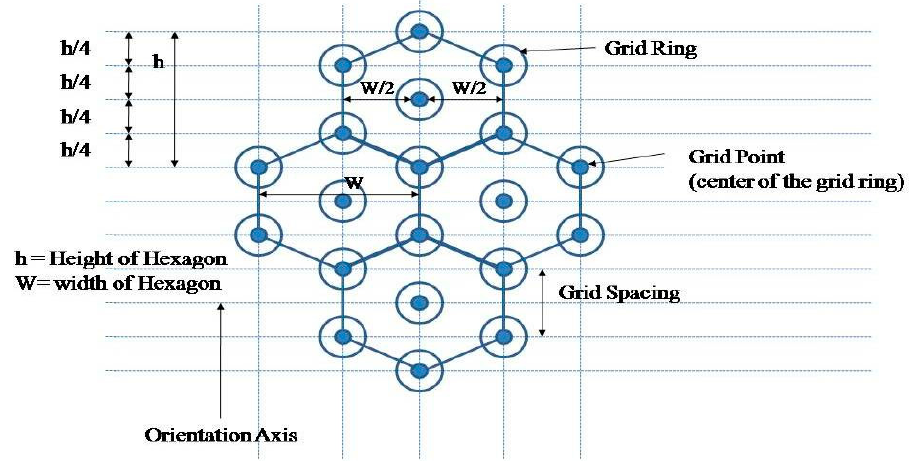
Figure 9. The geometry of hexagonal grid points.